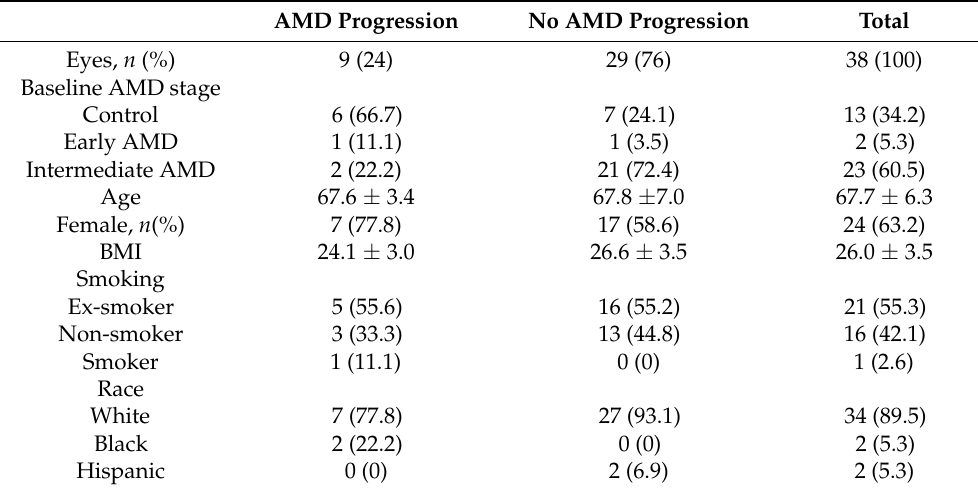
Table 4. Demographics of the included eyes with data available on dark adaptation.